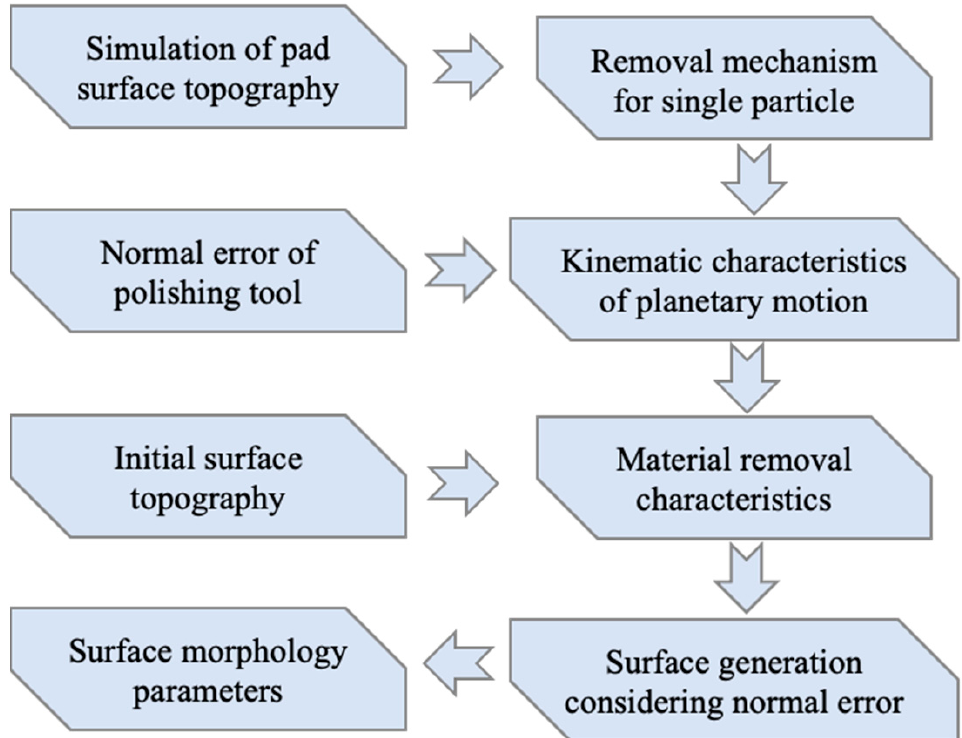
Figure 1. Flowchart of the theoretical modeling process for CCOS.